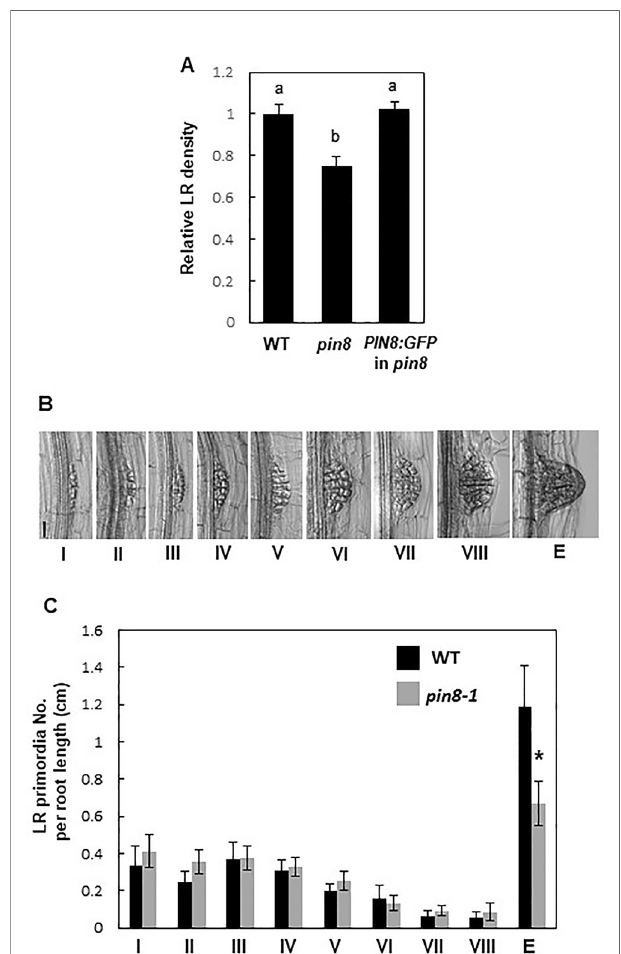
FIGURE 1 | PIN8 affects lateral root (LR) development. (A) LR densities (number of emerged LRs per cm of the root) of the wild type (WT), pin8 mutant, and pin8 -complementation line expressing ProPIN8:PIN8:GFP . Data represent mean ± standard error [SE; n = 142 – 261 seedlings; from seven independent lines for ProPIN8:PIN8:GFP in pin8 ( Supplementary Figure S2C )]. Statistically signi fi cant differences were determined using one-way analysis of variance (ANOVA) with Tukey's unequal N honest signi fi cant difference (HSD) post hoc test and are denoted with different letters ( P < 0.05). (B) Representative images of LR primordia at different developmental stages. Scale bar = 40 µm. (C) Distribution of LR primordia at different developmental stages. Data represent mean ± SE ( n = 17 – 20 seedlings). “ E ” in ( B, C ) indicates the emerged LR primordia. Signi fi cant differences compared with WT are indicated using asterisks (* P < 0.05; Student's t